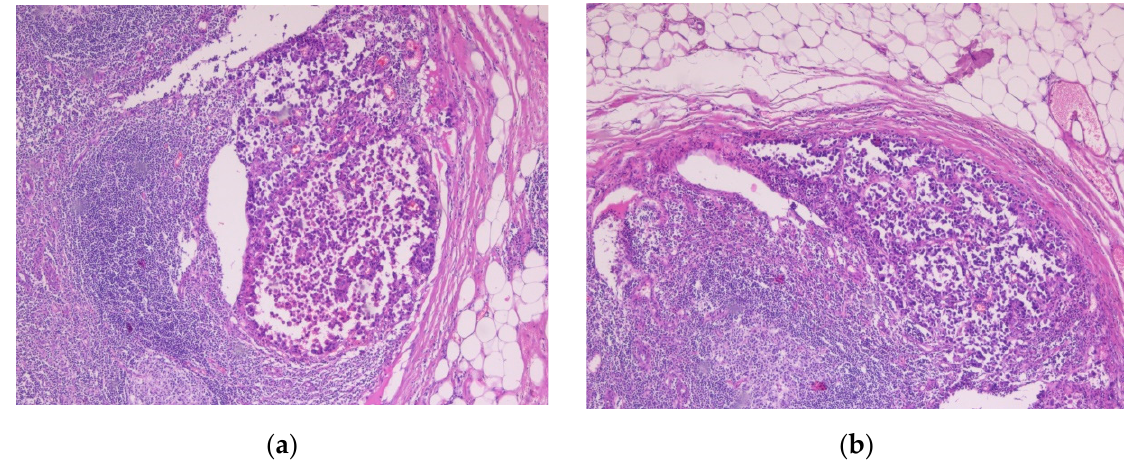
Figure 11. Lymph node metastasis. ( a , b ) Tumor proliferation below the lymph node capsule, extending towards the center of the lymph node. Both images were taken at 5× magnification. (Collection of Pathology Department SCJ Mure ș ).